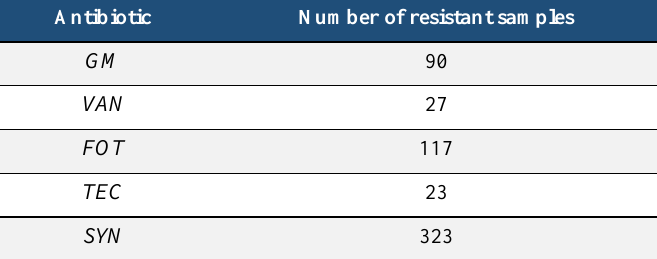
Table 3. The number of resistant samples to each antibiotic Antibiotic Number of resistant